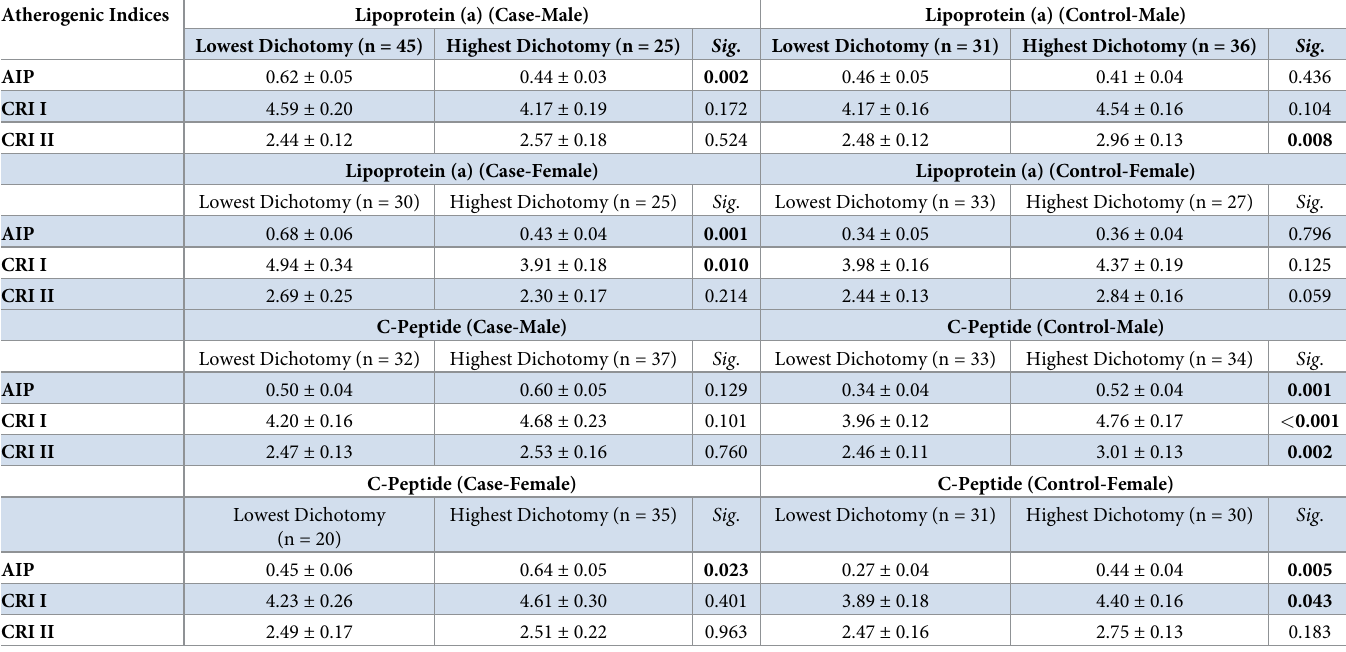
Table 4. Mean ± SE � of atherogenic indices¶ of plasma according to lowest and highest dichotomies of lipoprotein (a) and C-Peptide. Atherogenic